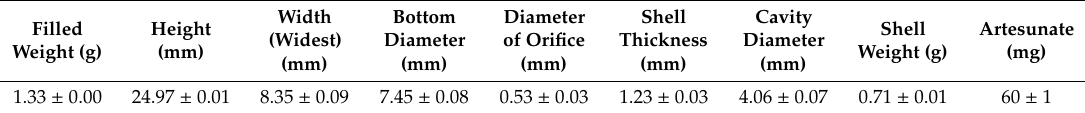
Figure 2. Suppositories containing artesunate: ( a ) a suppository containing artesunate-loaded micelles (low Kolliphor P470, top) and a free-artesunate suppository (bottom); ( b ) a free-artesunate suppository (left) and a 3D-printed suppository containing artesunate (right); ( c ) a cross-section of a 3D-printed suppository shell. Table 2. Physical properties of 3D-printed suppositories carrying artesunate.